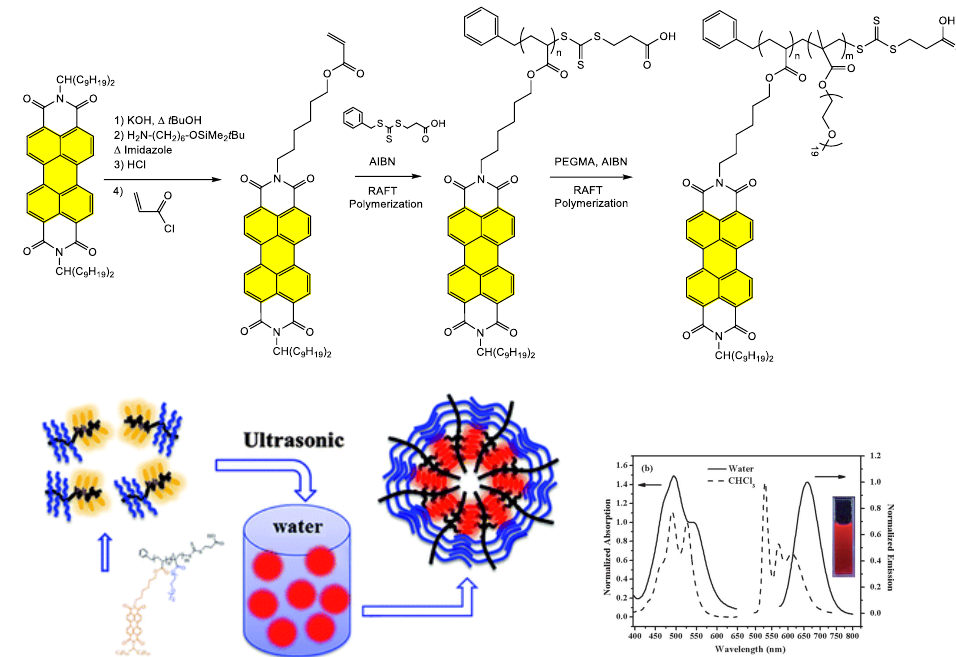
Figure 9. Synthesis of copolymer PPDA-b-P(PEGMA); schematic representation of the preparation of PPDA-b-P(PEGMA) PNPs; normalized absorption and emission of the PPDA-b-P(PEGMA) in water (solid line) and chloroform (dashed line). The inset shows the PNPs in water exposed to 365 nm excitation. Reprinted with permission from reference [112]. Copyright 2014 Royal Society of Chemistry.